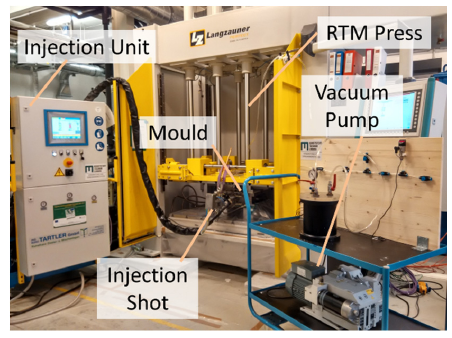
Figure 3. Production setup while injecting the resin system into the FML preform.